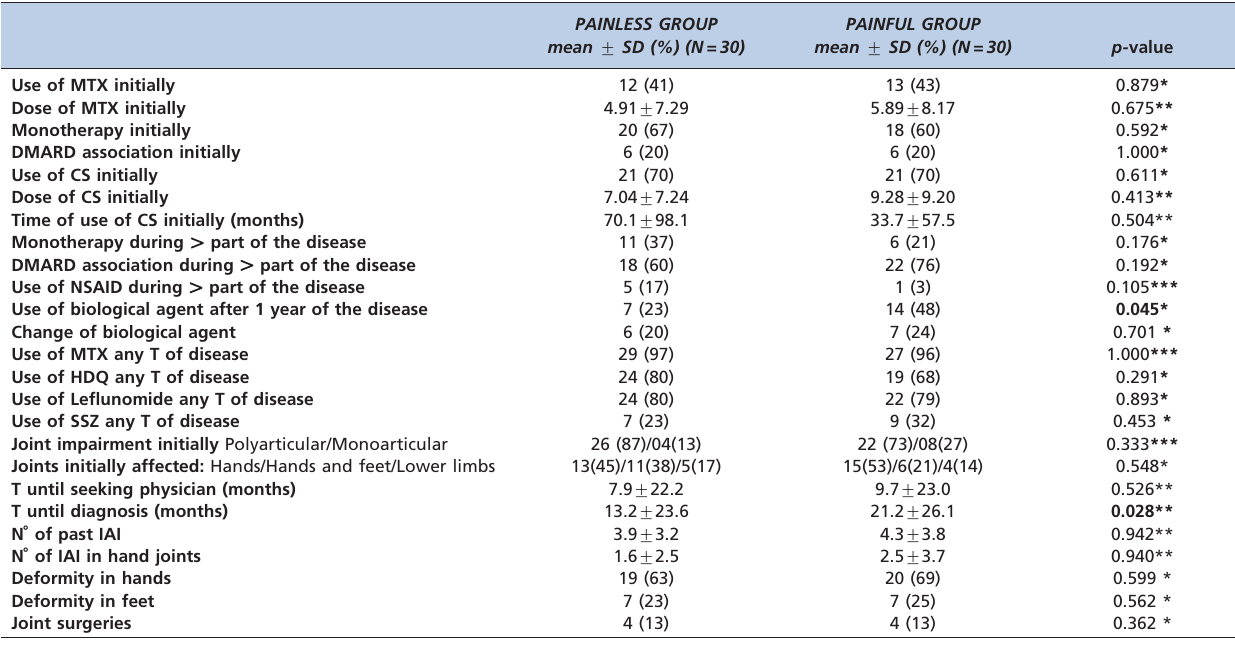
Table 3 - Past disease variables of the groups.